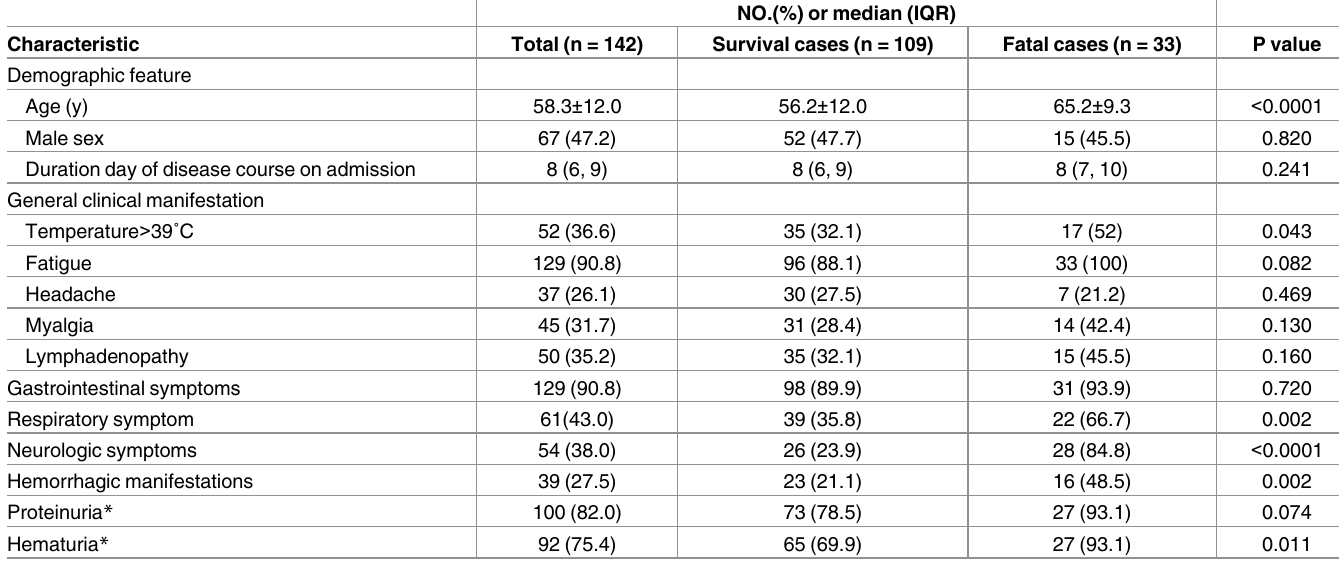
Table 1. Clinical characteristics of hospitalized case-patients with confirmed severefever with thrombocytopenia syndrome.